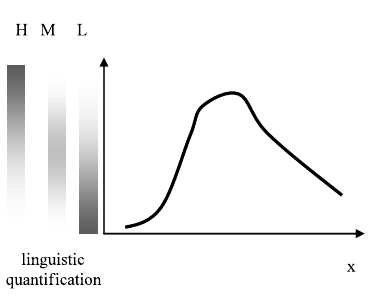
Figure 6. Computing the interval representation of numeric values through the principle of justifiable granularity by elevating and suppressing respective membership grades Figure 7. Fuzzy set of type-1 and its linguistic interpretation through fuzzy sets of linguistic